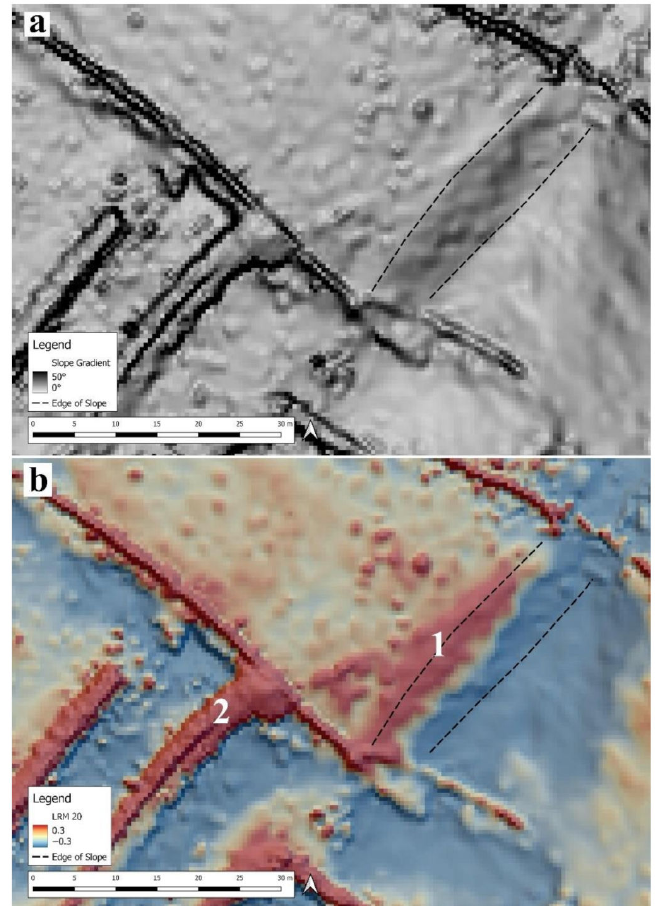
Figure 14. ( a ) The slope map shows a 8 m wide slope with a gradient of 25 ◦ . The edges of the slope are marked with pecked lines. ( b ) In the LRM (here a combination of LRM(20) and MH), features “1” and “2” have similar signatures, which suggests that they are raised areas that might be interpreted as banks. However, feature “1” is part of the slope (indicated by the pecked lines), rather than a bank and ditch as implied by the